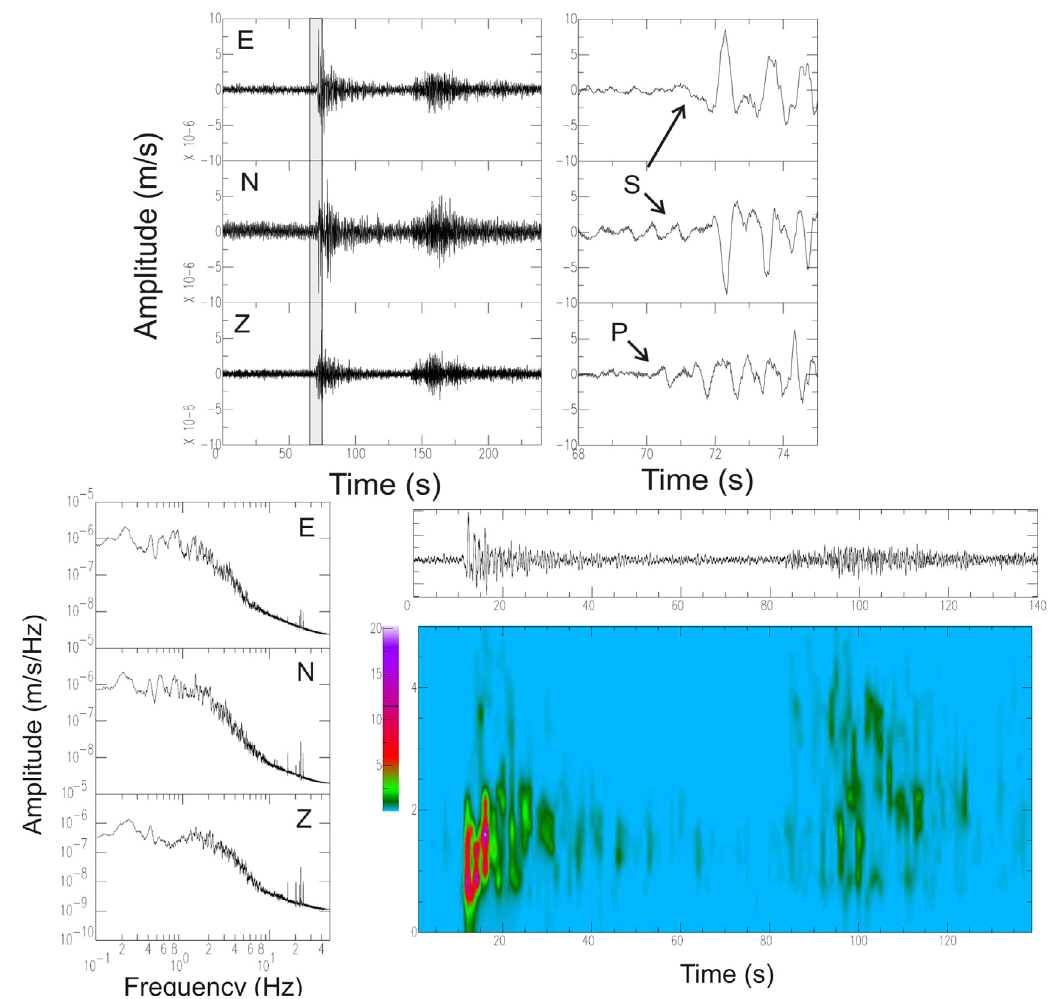
Figure 10. Top left: the three-components waveforms of the very-low-frequency earthquake recorded at OVO broadband sensor. On the top- right we show a zoom on the P and S-wave arrivals. Bottom left: displacement spectrum of the 3 waveforms shown above. Bottom right: spectrogram of the vertical component of the same event recorded at